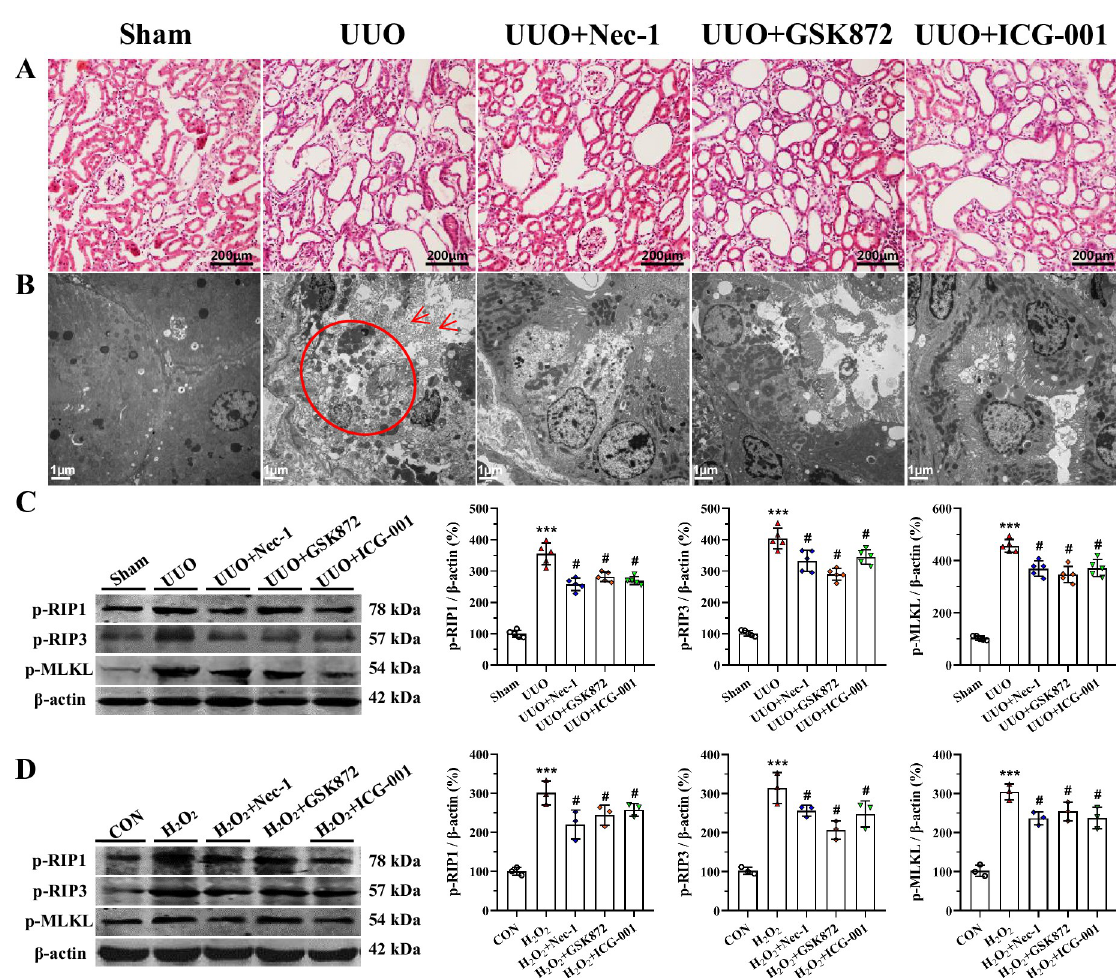
Fig 1. Representative photomicrographs of HE staining (A), transmission electron microscopy (B), and immunoblotting analysis of RIP1-RIP3-MLKL protein in vivo (C) and in vitro (D). UUO caused necrosis within the tubular epithelium (circle) and abscission of microvilli in epithelial cells (arrows), whereas these changes were attenuated by RIP inhibitor or ICG-001. ��� P < 0.01 vs. sham or control; # P < 0.05 vs. UUO or H 2 O 2 .